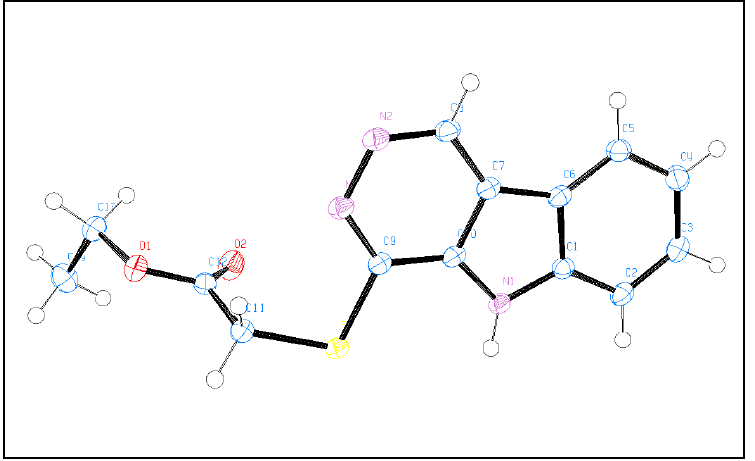
Figure 2. ORTEP projection of compound 6 ( CCDC 2133074, see in Supplementary Materials) .